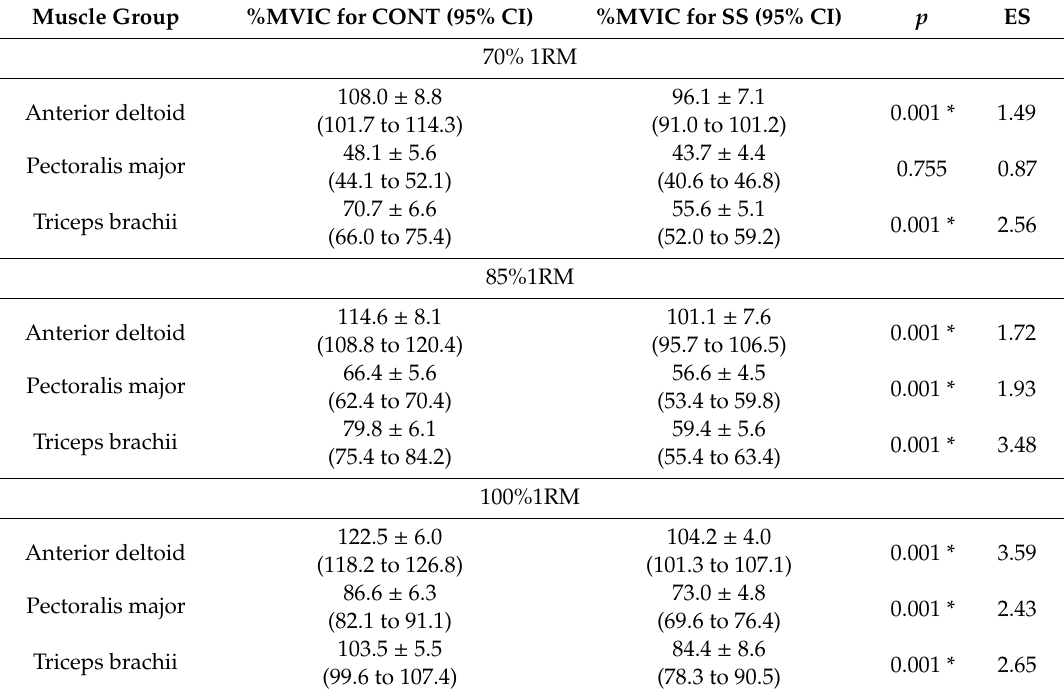
Table 5. Results of the main multi interaction e ff ect of condition × load × muscle